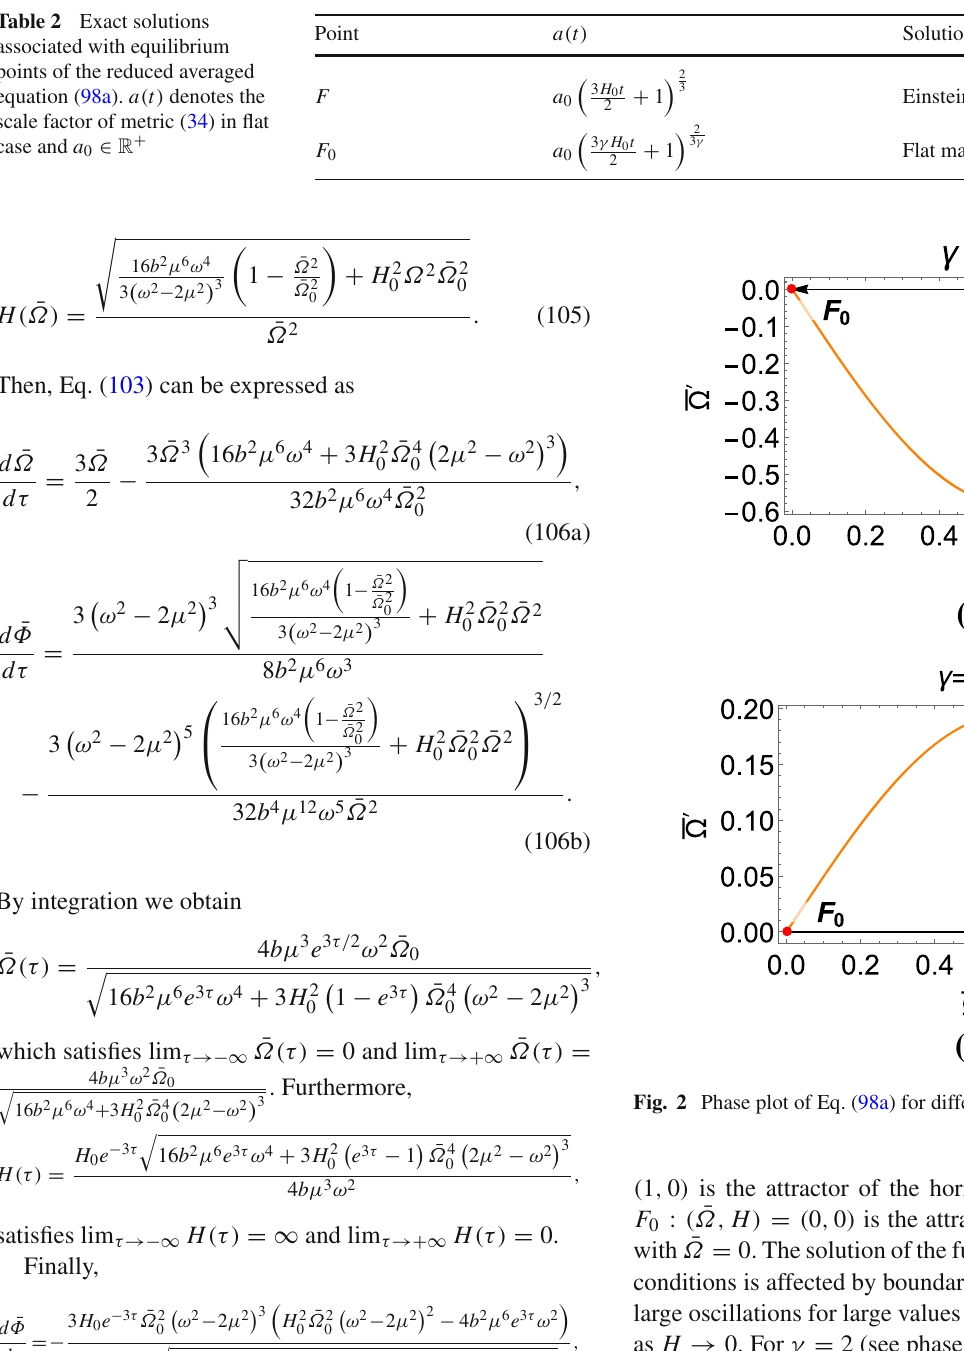
¯ Ω = 1 and has ¯ Ω = 0 tends to F 0 0